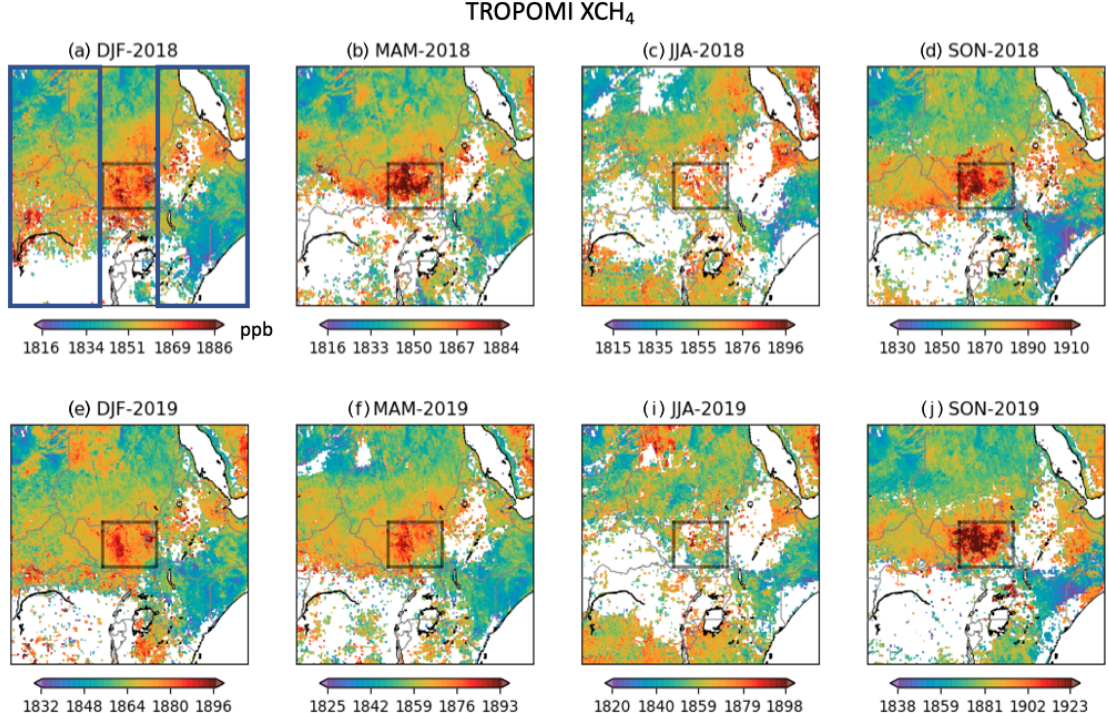
Figure 2. Seasonally averaged TROPOMI XCH 4 (ppb) at 0.1 ◦ × 0.1 ◦ resolution. The black rectangle at the center of each panel shows the SSWR source region. The area outside it is used as the background region. XCH 4 is corrected for large-scale latitudinal variations by subtracting a third-order polynomial fit using the region shown by blue rectangles in panel (a) . The region excludes the longitudes of the source region. Note that DJF includes December of the previous